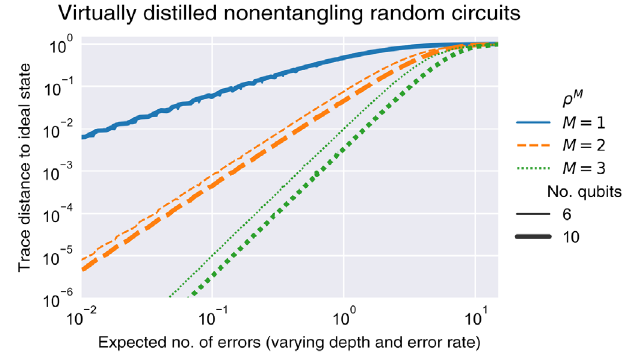
FIG. 4. The error in the unmitigated noisy states ( M ¼ 1 ) and the states accessed by virtual distillation ( M ¼ 2 , 3) for a variety of nonentangling random circuits at two different system sizes (differentiated by thickness of markers). We plot the error quantified by the trace distance to the state obtained from noiseless evolution as a function of the expected number of single-qubit depolarizing errors resulting from varying both the error rate and number of gates. Unlike other cases, for these nonentangling circuits, the eigenvalue floor vanishes, and we see exponential suppression in the number of copies.